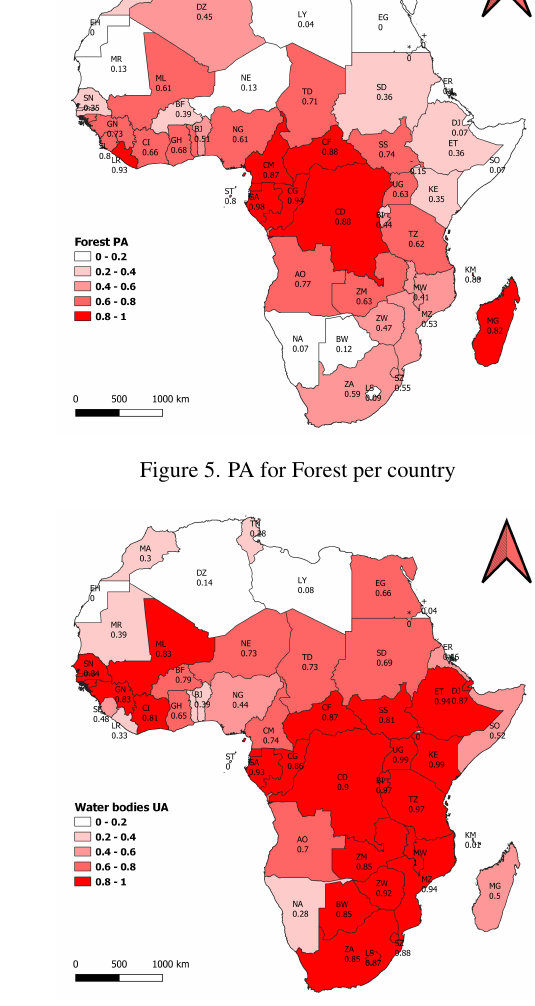
Figure 6. UA for Water bodies per